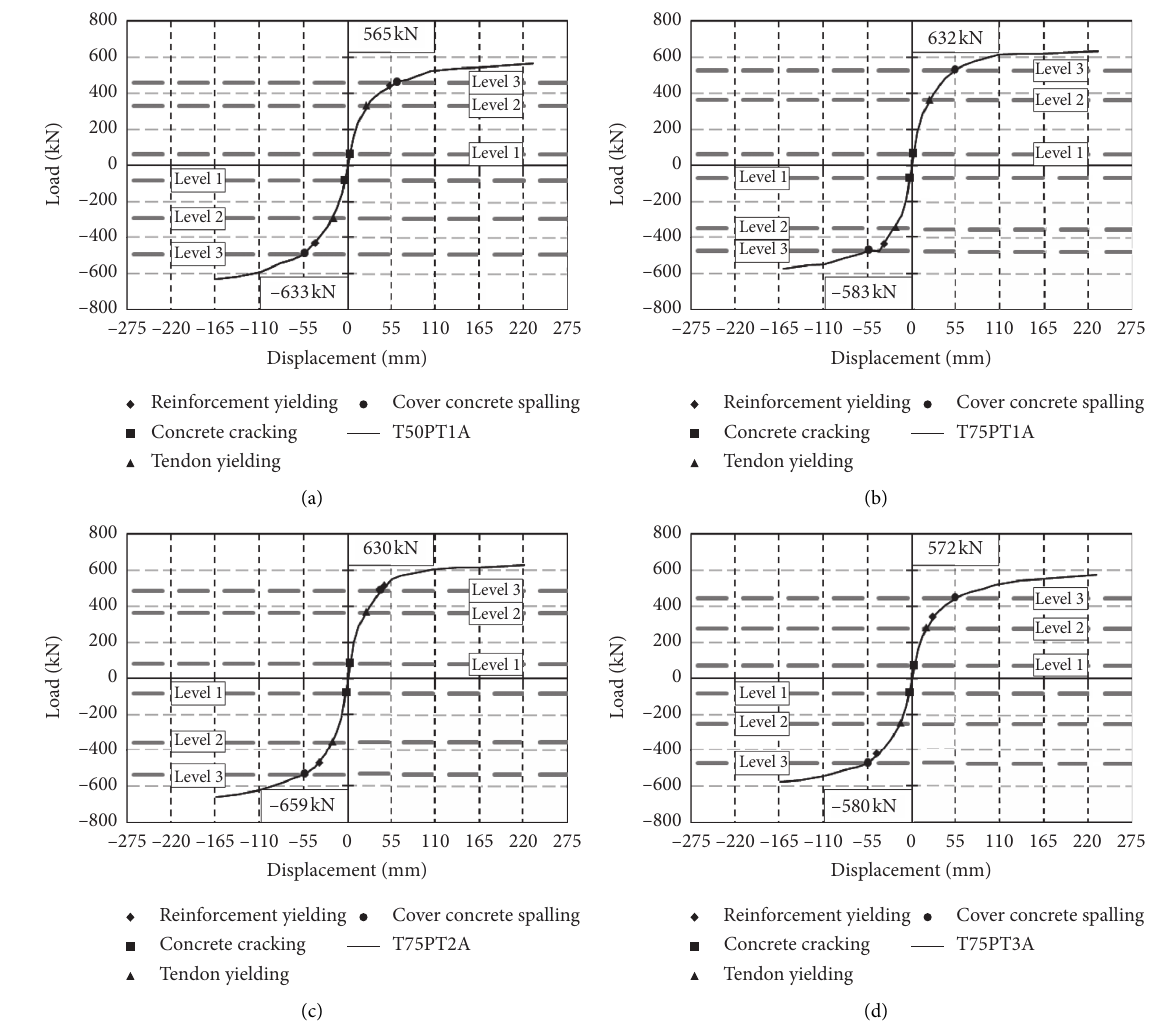
Figure 6: Load-displacement envelope curves according to performance levels. (a) T50PT1A. (b) T75PT1A. (c) T75PT2A. (d)